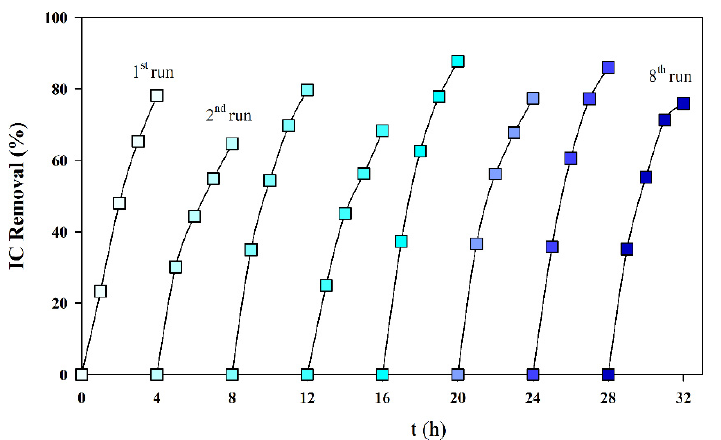
Figure 6. IC removal in successive galvanostatic assays run without cleaning the deposit formed in the cathode surface. Solution S; I = 0.1 A; Anode—BDD 20 cm 2 ; Cathode—SS 20 cm 2 ; Stirring speed 1000 rpm.